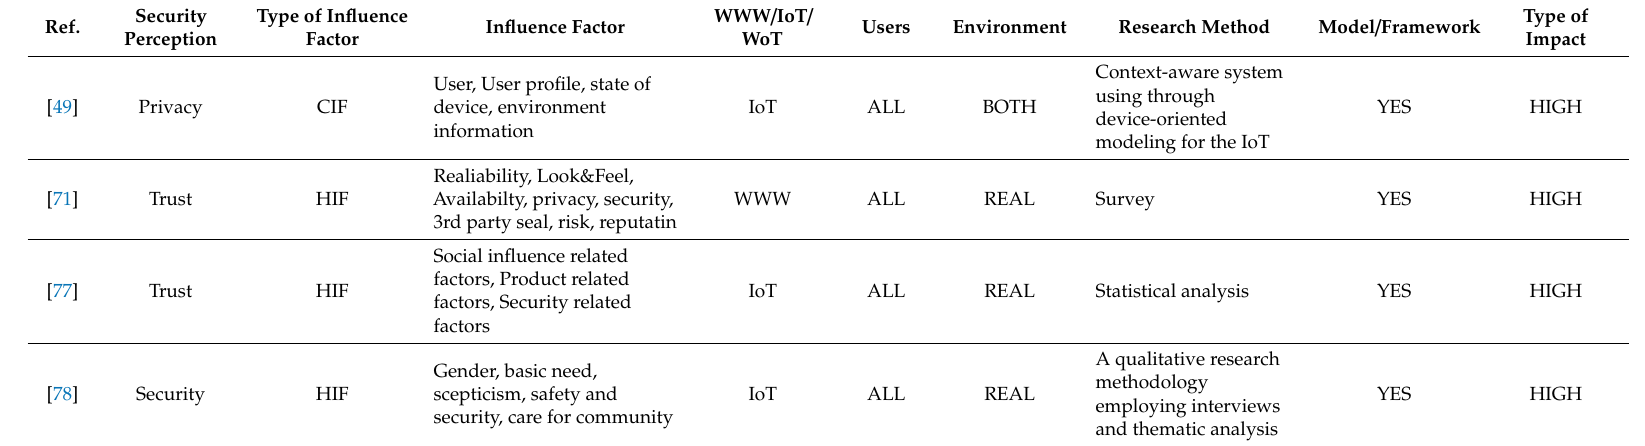
Table A3. The impact of influence factors on perceived